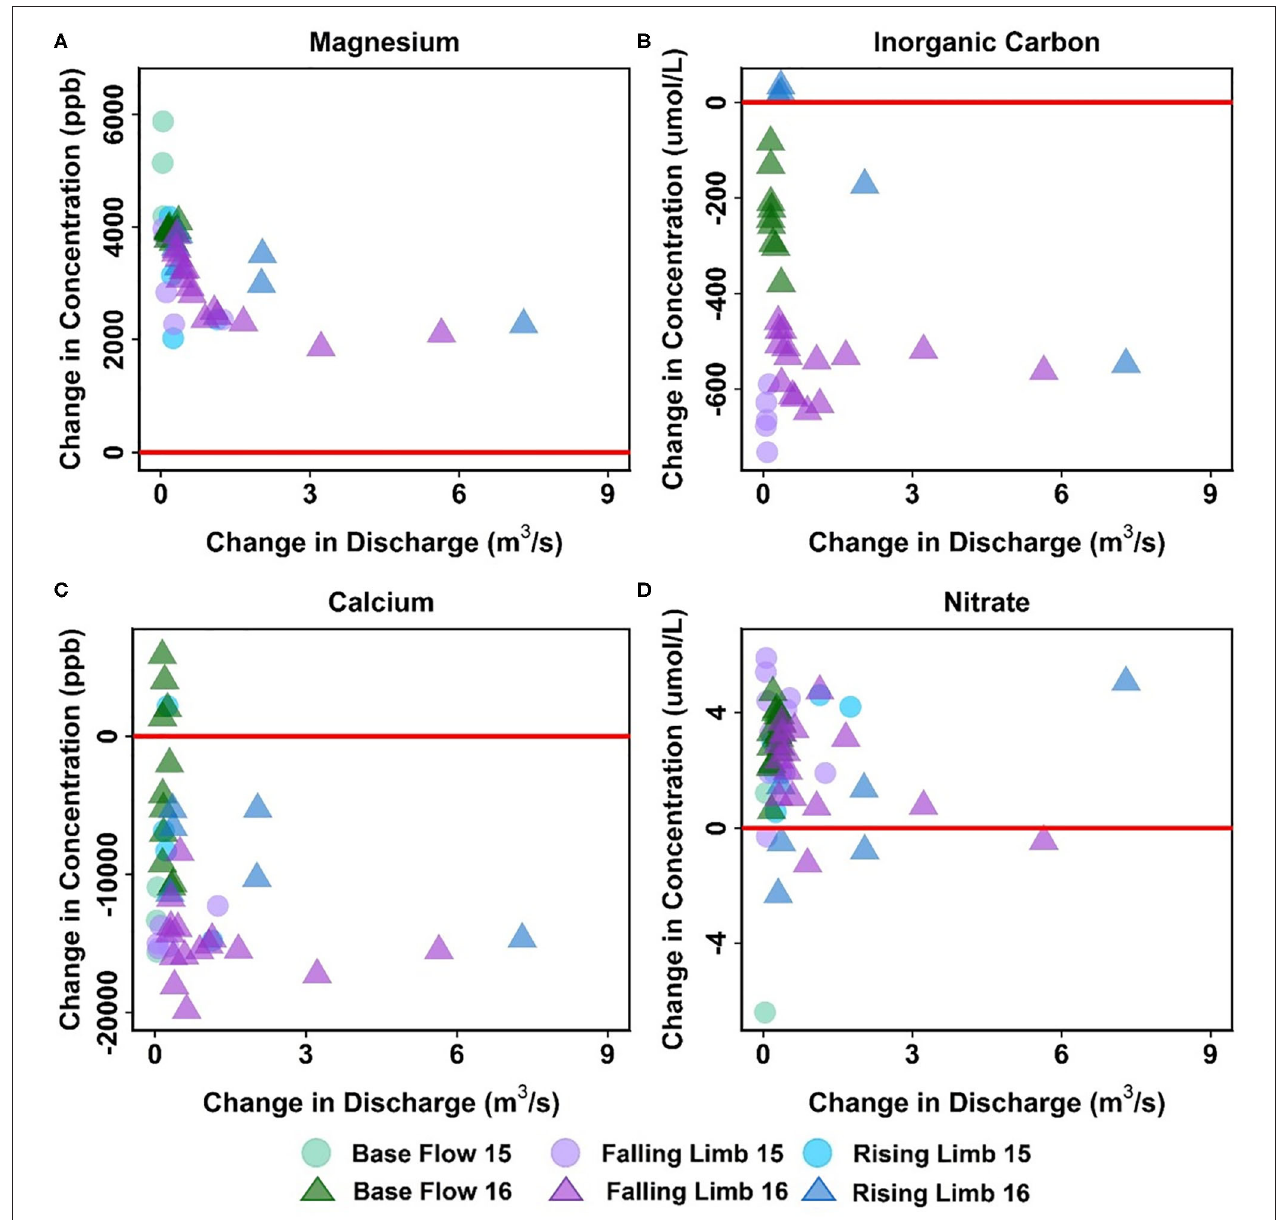
FIGURE 8 | Differential C-Q analyses for the upstream reach showing changes in concentrations of (A) Ca, (B) DIC, (C) Mg, and (D) NO 3 relative to changes in flow. For clarity, gains and losses of solutes are demarcated relative to a solid red “no change”